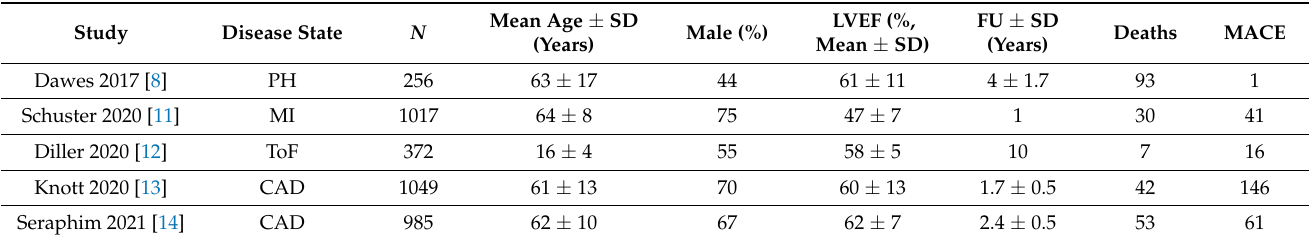
Table 1. A summary of the baseline characteristics and outcomes of the studies included in the systematic